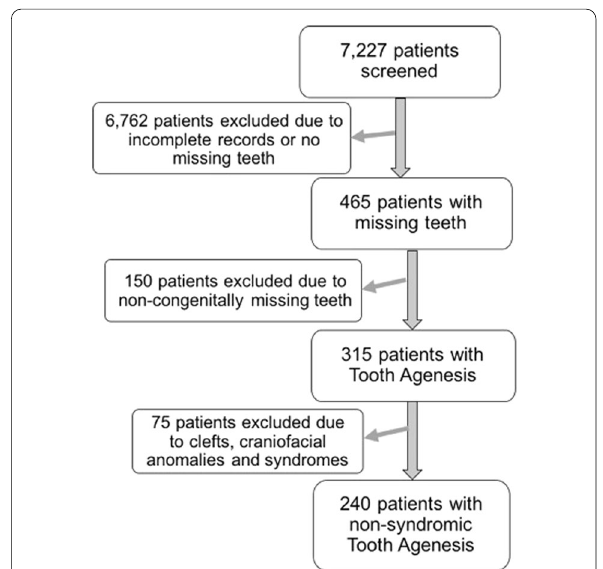
Fig. 1 Flow diagram of patients’ selection for the study